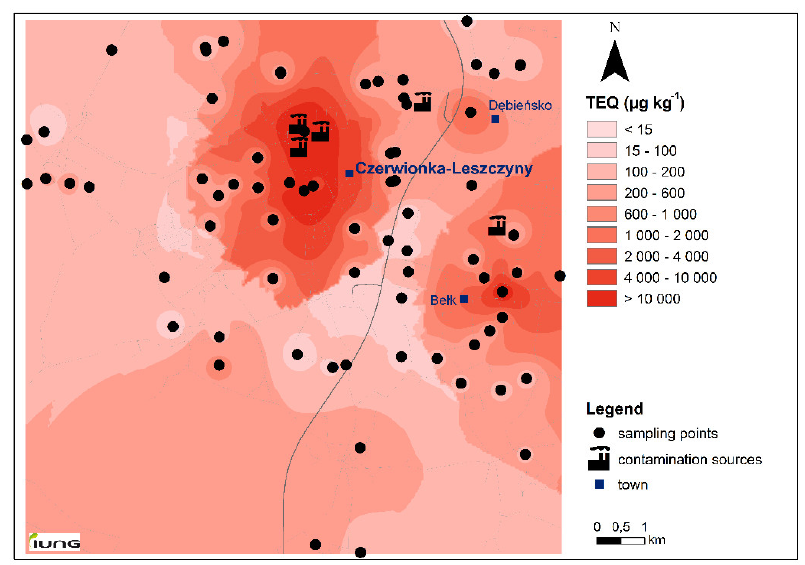
Figure 3. Spatial distribution of the toxic equivalent concentration (TEQ) of 16PAHs in the study area; TEQ class limits correspond to different guidelines values for the protection of human health.